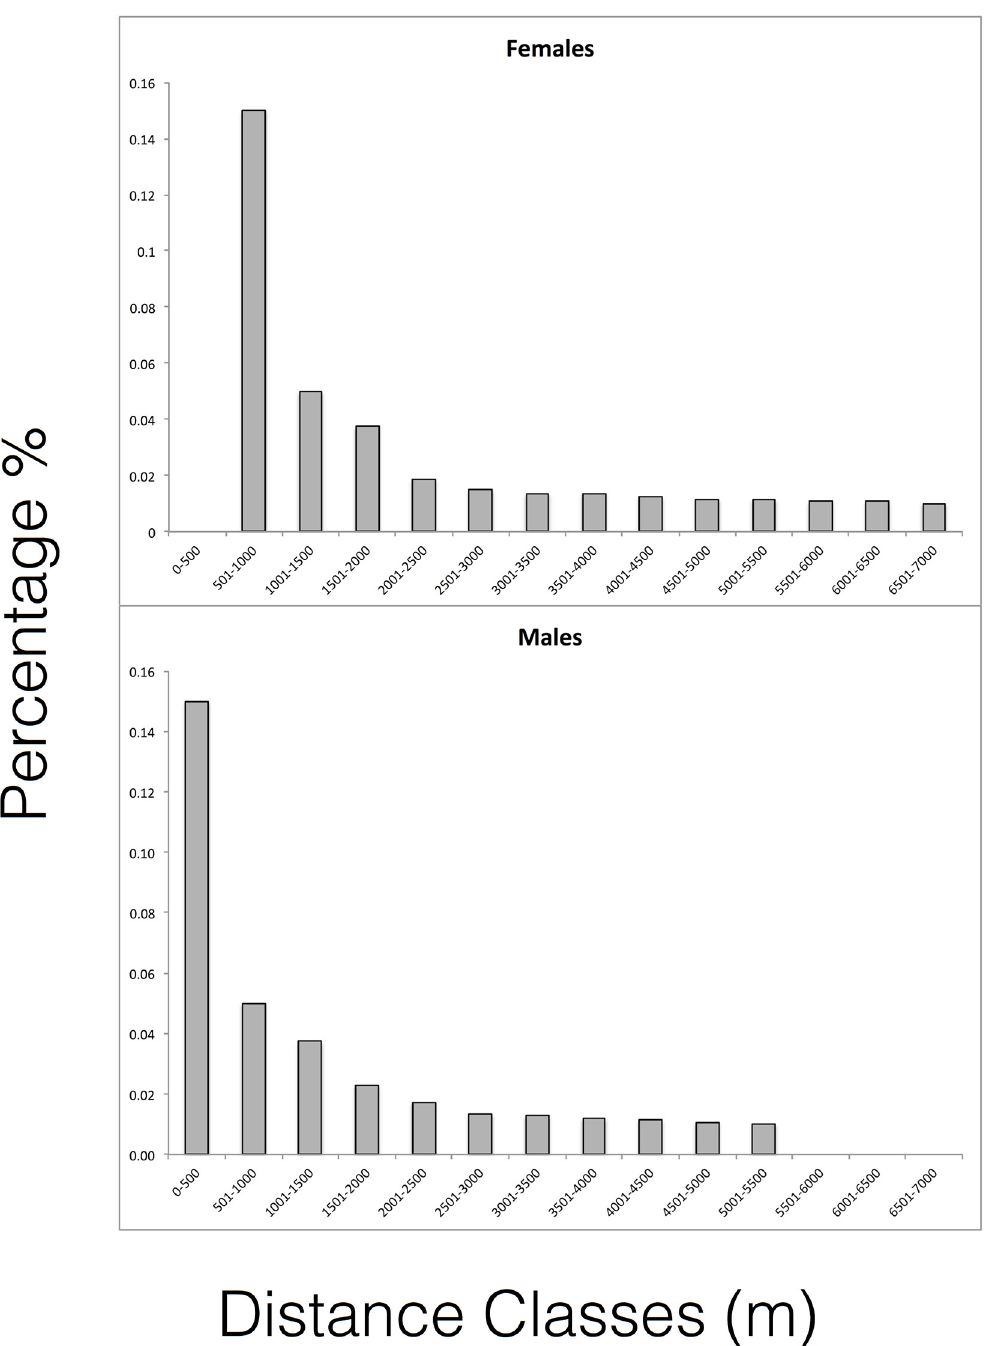
Fig 3. Plots showing the inverse cumulative proportions that represent the decay function fitted to the a) female and b) male dispersal distances. The x-axis shows the distance in meters that span the sampled landscape, divided into 500m distance classes. The y-axis represents the proportion. The negative inverse cumulative distribution of distances for females start at the second distance class and extends all the way to the final distance class, in contrast to the male